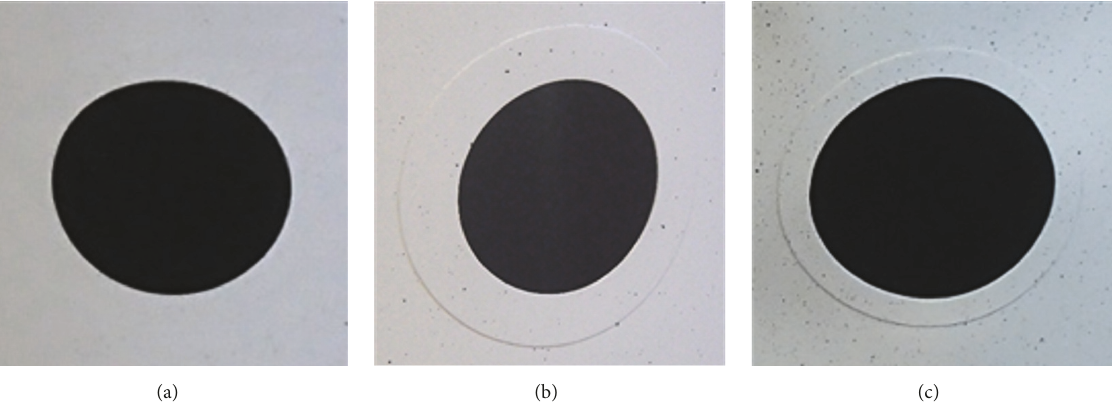
Figure 2: Different cutout edge conditions: unreinforced cutout (a) and cutouts with reinforcing rings of 20 (b) and 10 (c) mm width.